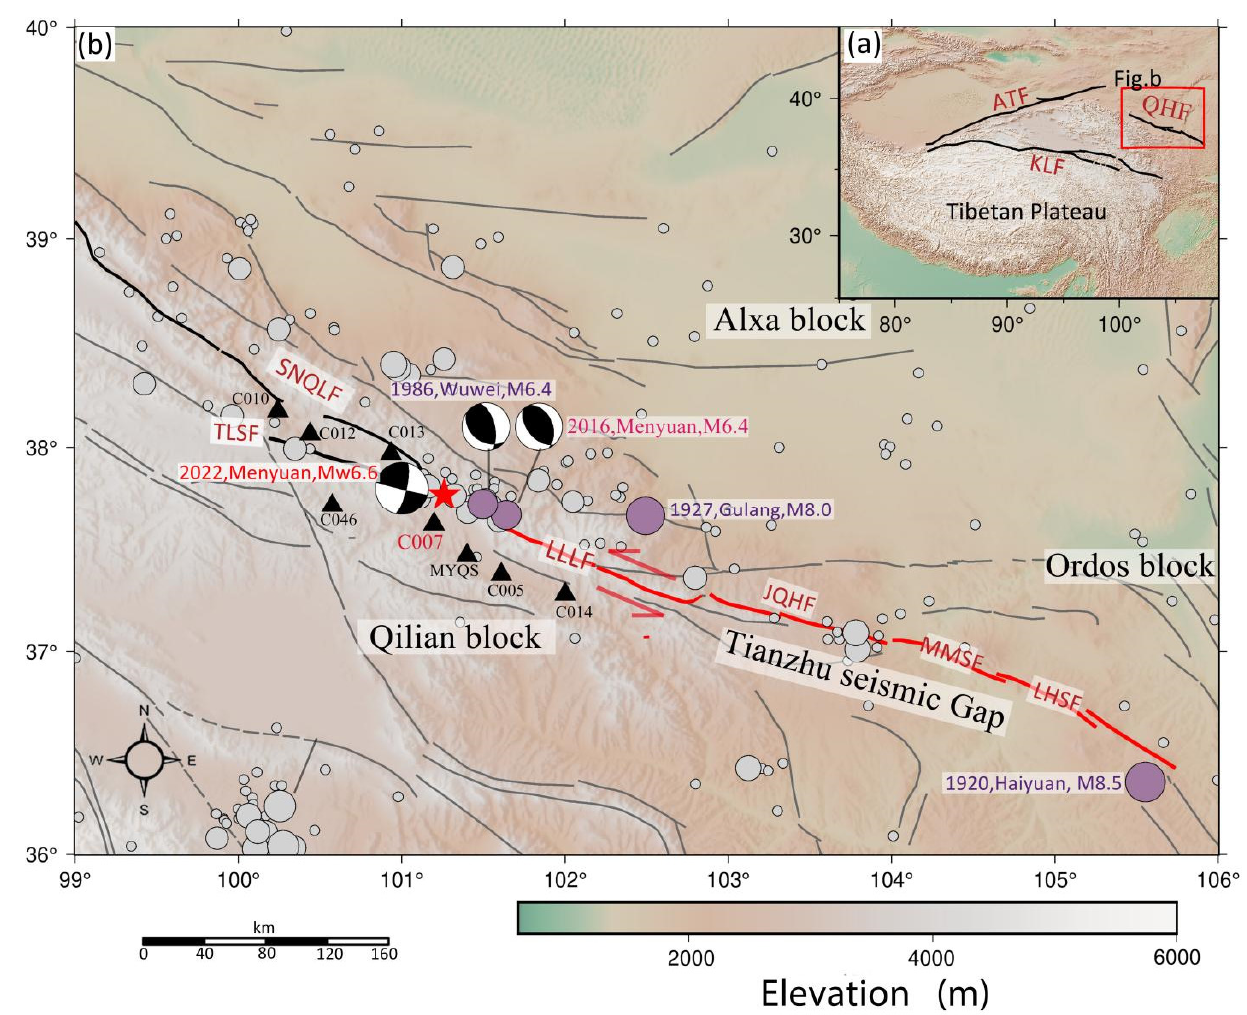
Figure 1. ( a ) Major active faults on the northeastern margin of the Tibetan Plateau. ATF: Altyn Tagh fault; KLF: Kunlun fault; QHF: Qianlian–Haiyuan fault. ( b ) Tectonic setting of the 2022 Menyuan earthquake, gray and purple dots are historical earthquakes. The red star is the epicenter of the 2022 Menyuan earthquake from the USGS. Black triangles are locations of intensity meter used in this study. Thick red line is the Tianzhu seismic gap. SNQLF: Sunan–Qilian fault; TLSF: Tuolaishan fault; LLLF: Lenglongling fault; JQHF: Jinqianghe fault; MMSF: Maomaoshan fault; LHSF: Laohushan fault.